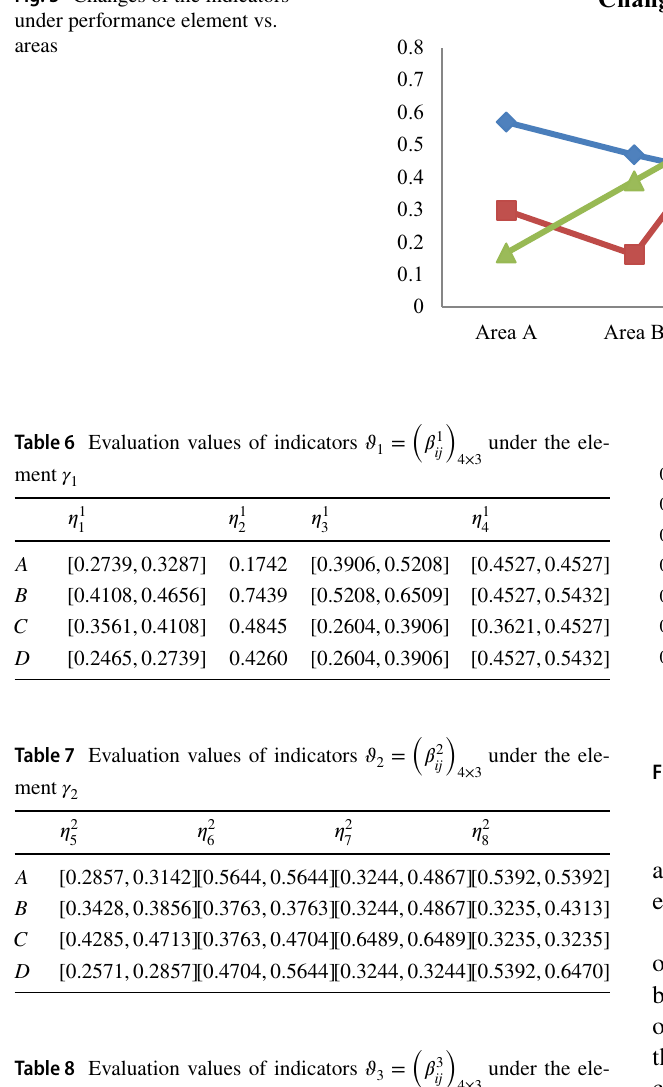
Table 8 Evaluation values of indicators 𝜗 3 = ment 𝛾 3